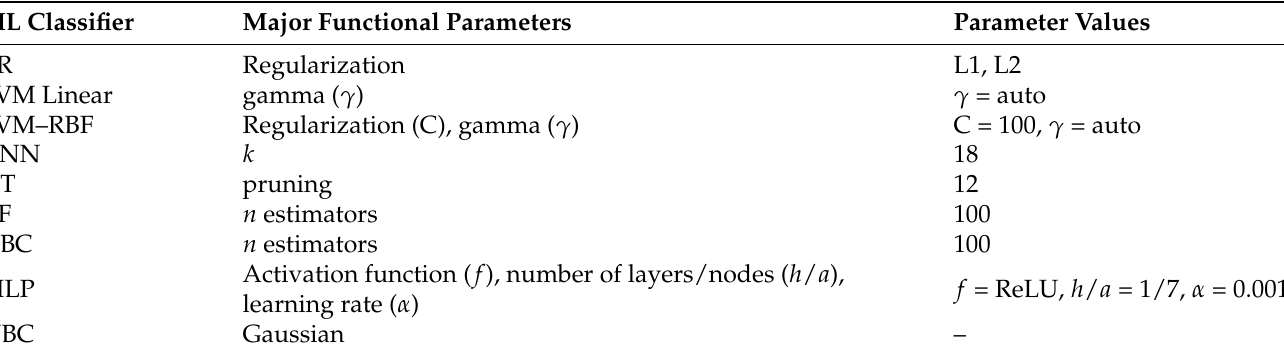
Table 4. ML classifiers and their respective